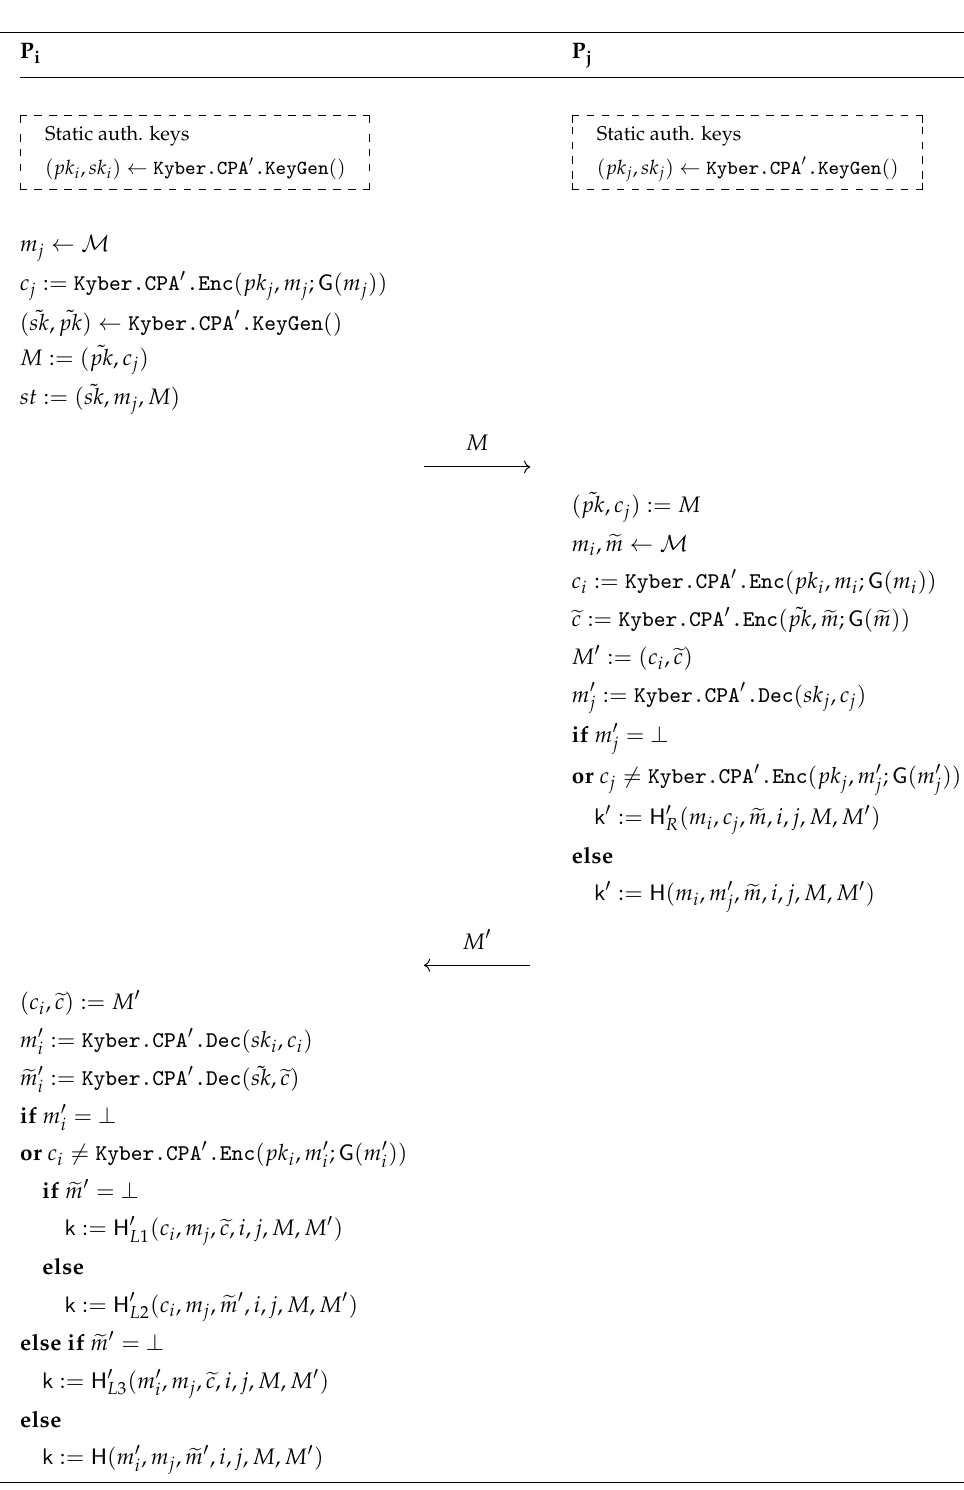
Figure 4. Kyber.2AKE